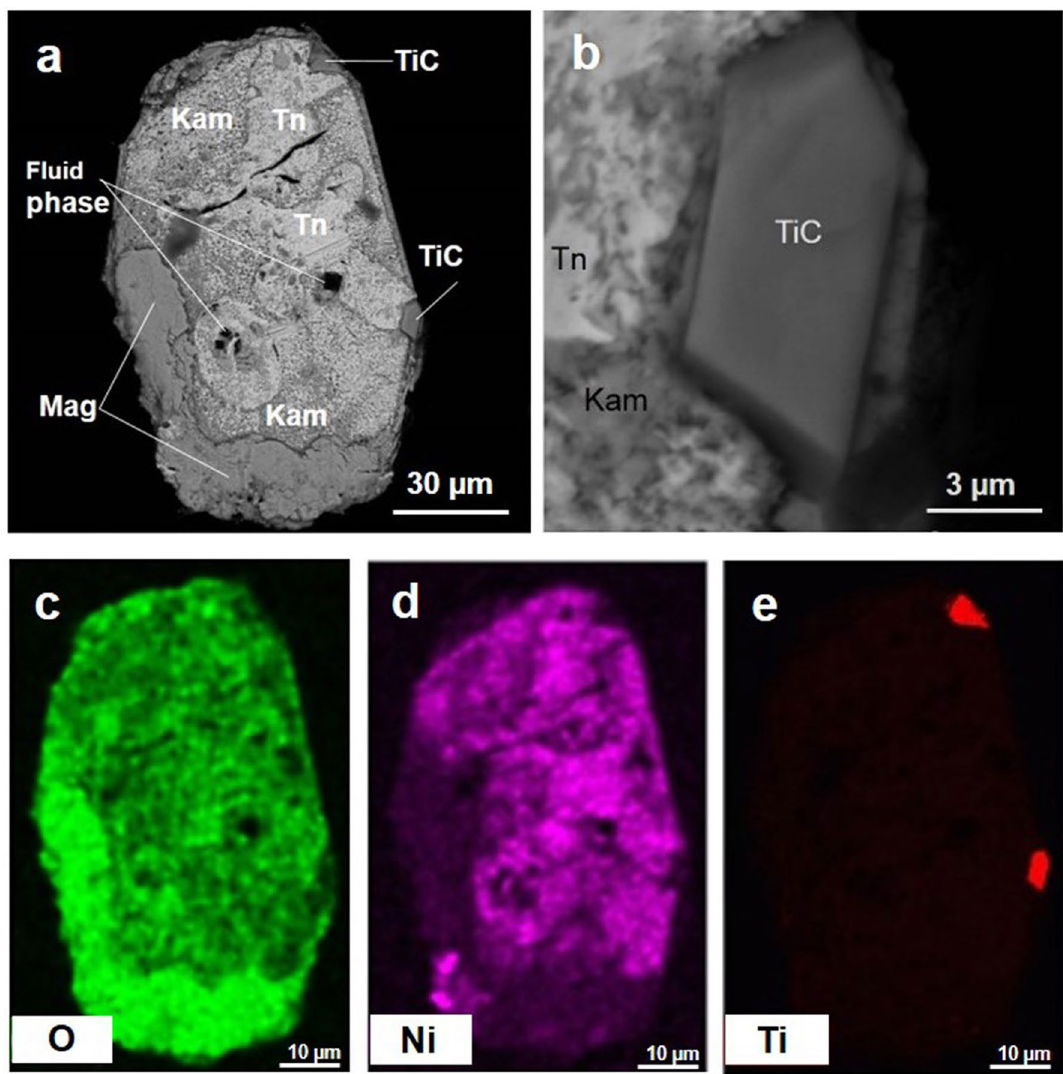
Figure 3. Melt inclusion in synthetic diamond from Fe–Ni–Ti–C system: BSE image of the common shape of inclusion shown on ( a ), and its enlarged fragment ( b ); ( c – e ) element maps for O, Ni and Ti. Tn taenite, Kam kamasite, Mag magnetite, TiC titanium